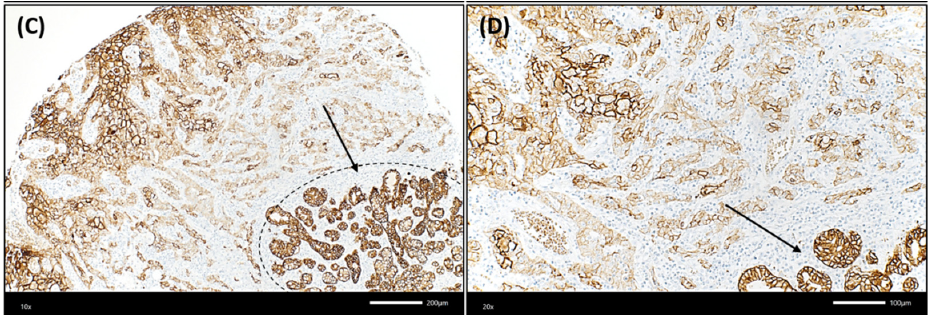
Figure 4. Illustration of an OSCC case that showed lower Trop-2 expression in the very peripheral tumor cells compared to more central cancer cells. ( A , B ): The squamous cell carcinoma showed a rather solid growth pattern centrally, whereas tumor cells grew in smaller cell clusters at the very peripheral invasion border, which was located near non-neoplastic salivary glands. The dashed black line in ( A ) and the black arrow in ( A , B ) highlight the seromucous salivary glands (hematoxylin & eosin, each ×200 magnification). In ( C , D ), a decrease of Trop-2 expression on cancer cells growing in smaller cell clusters at the invasion border, close to salivary glands, can be detected. This is in contrast to the more centrally located larger tumor cell nests, which show a higher Trop-2 expression. The dashed black line in ( C ) and the black arrow in ( C , D ) highlight the seromucous salivary glands (Trop-2 immunohistochemistry, each ×200 magnification).